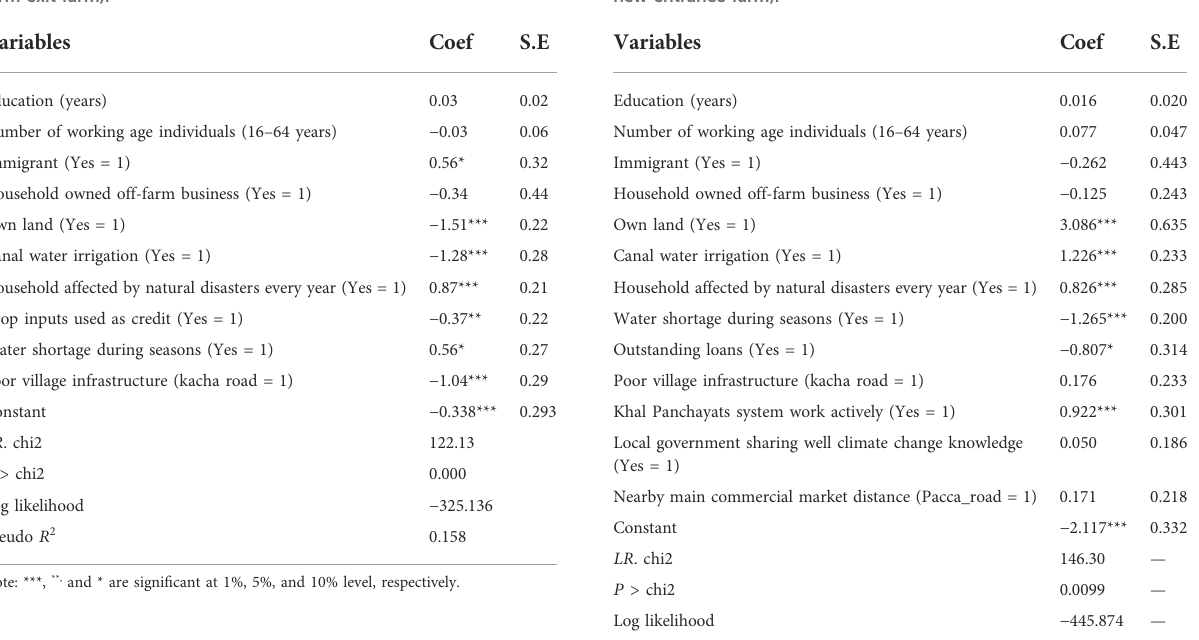
TABLE7Logitregressionresults (dependentvariablesarewhetherthe new entrance farm).